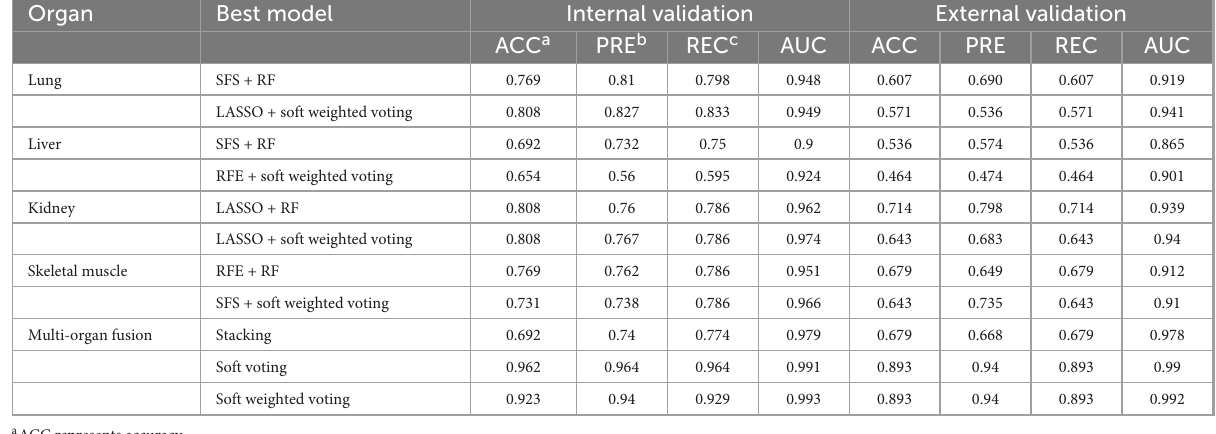
TABLE 4 The summary of all the optimal models is based on single organ sub-models, single organ ensemble models, and multi-organ fusion strategy. Organ